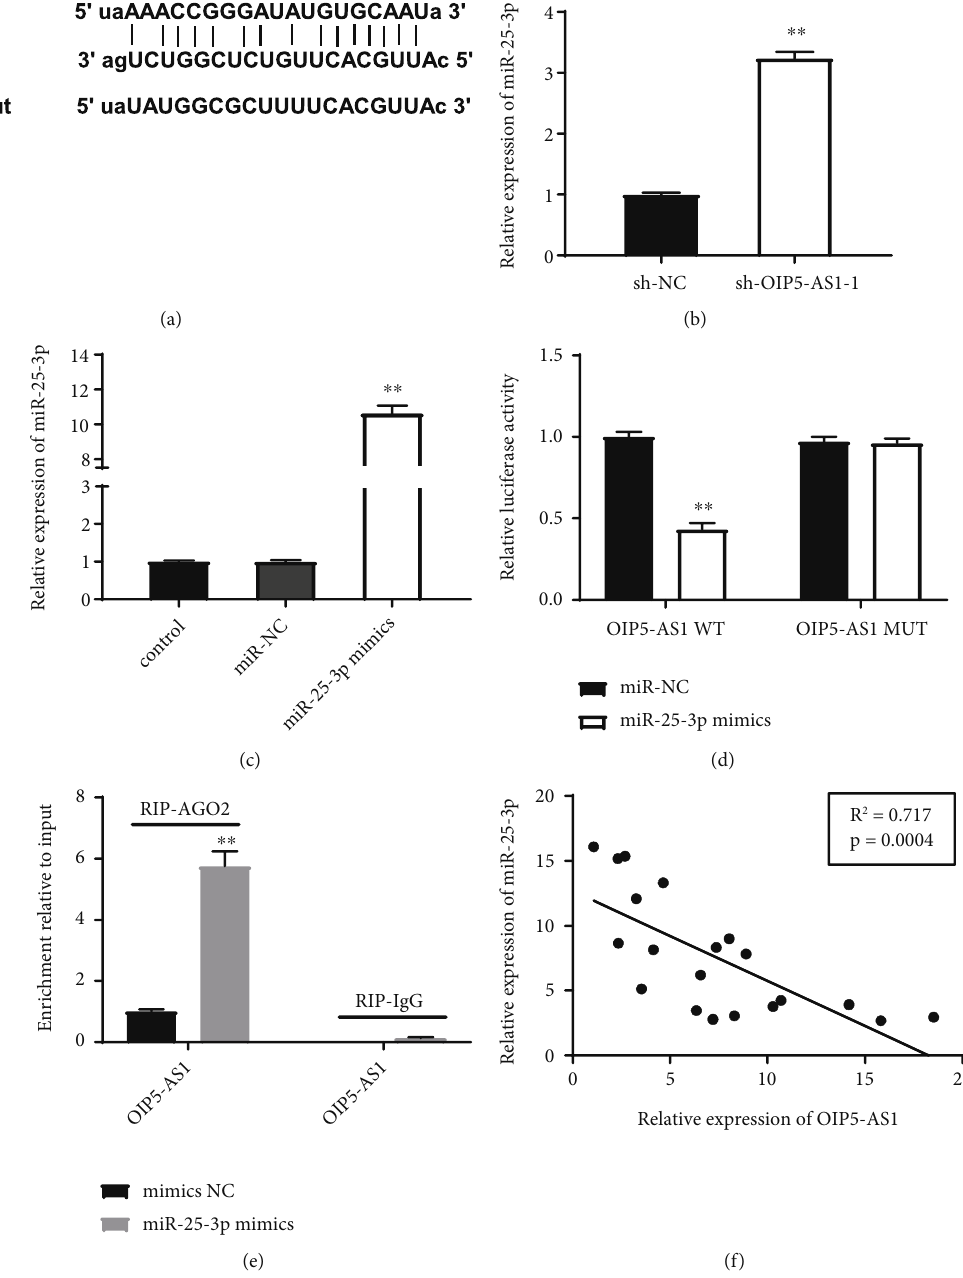
Figure 5: OIP5-AS1 directly targets miR-25-3p. (a) The WT binding site of OIP5-AS1 with miR-25-3p was predicted by starBase4.0 and relevant mutant sequence (MUT) was shown. (b) Relative expression of miR-25-3p in cells transfected with shOIP5-AS1 was detected by qRT-PCR. ** P < 0 : 01 versus sh-NC. (c) The transfection e ffi ciency of miR-25-3p mimics was detected by qRT-PCR. ** P < 0 : 01 versus sh- NC. (d and e) The relationship between OIP5-AS1 and miR-25-3p was validated by luciferase reporter assay (d) and RIP assay (e). (f) The expression relation between OIP5-AS1 and miR-25-3p was determined by Pearson ’ s correlation analysis. ** P < 0 : 01 versus